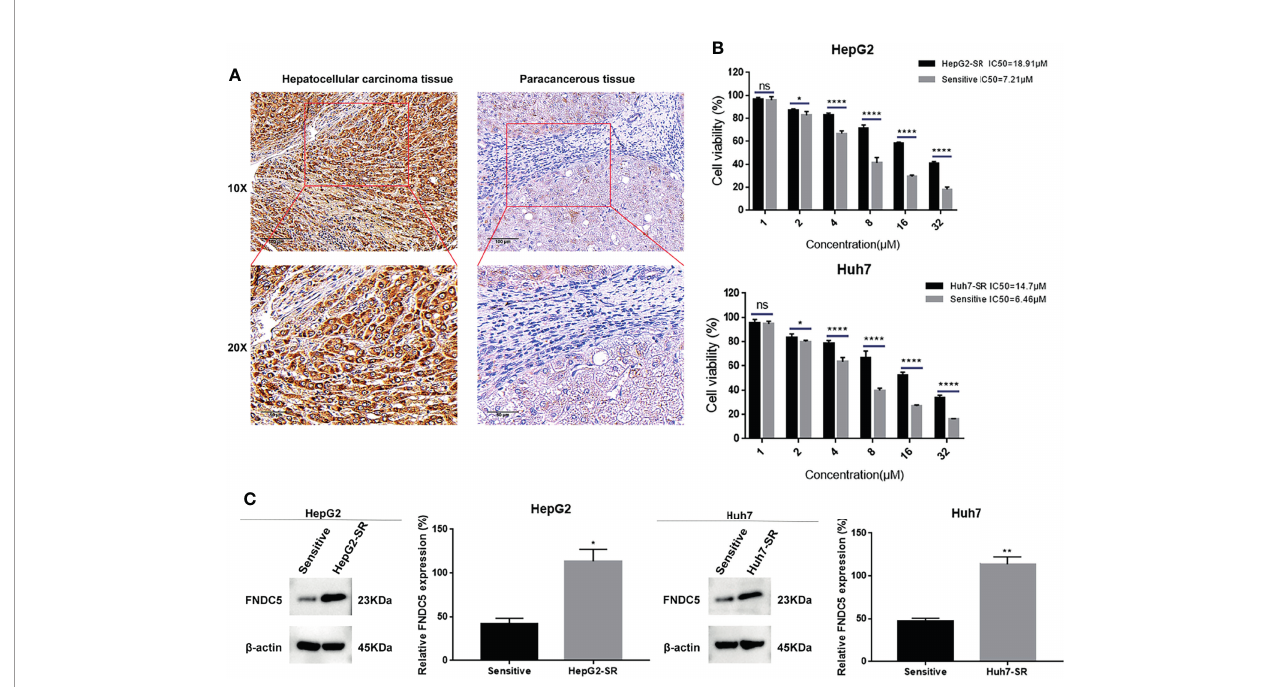
FIGURE 1 | Elevated levels of FNDC5 in sorafenib-resistant HCC cells. (A) FNDC5 is overexpressed in HCC tissues. (B) IC 50 values of sorafenib-sensitive and -resistant HCC cells were calculated using the CCK8 method after treating HCC cells with increasing concentrations of sorafenib for 24 h, and cell survival rates were measured. (C) Western blotting to detect differences in the expression of FNDC5 between sorafenib-sensitive and -resistant HCC cells. *Compared with the sorafenib-sensitive HCC cells, *p < 0.05, **p < 0.01, ****p < 0.0001. ns, no signi fi cant